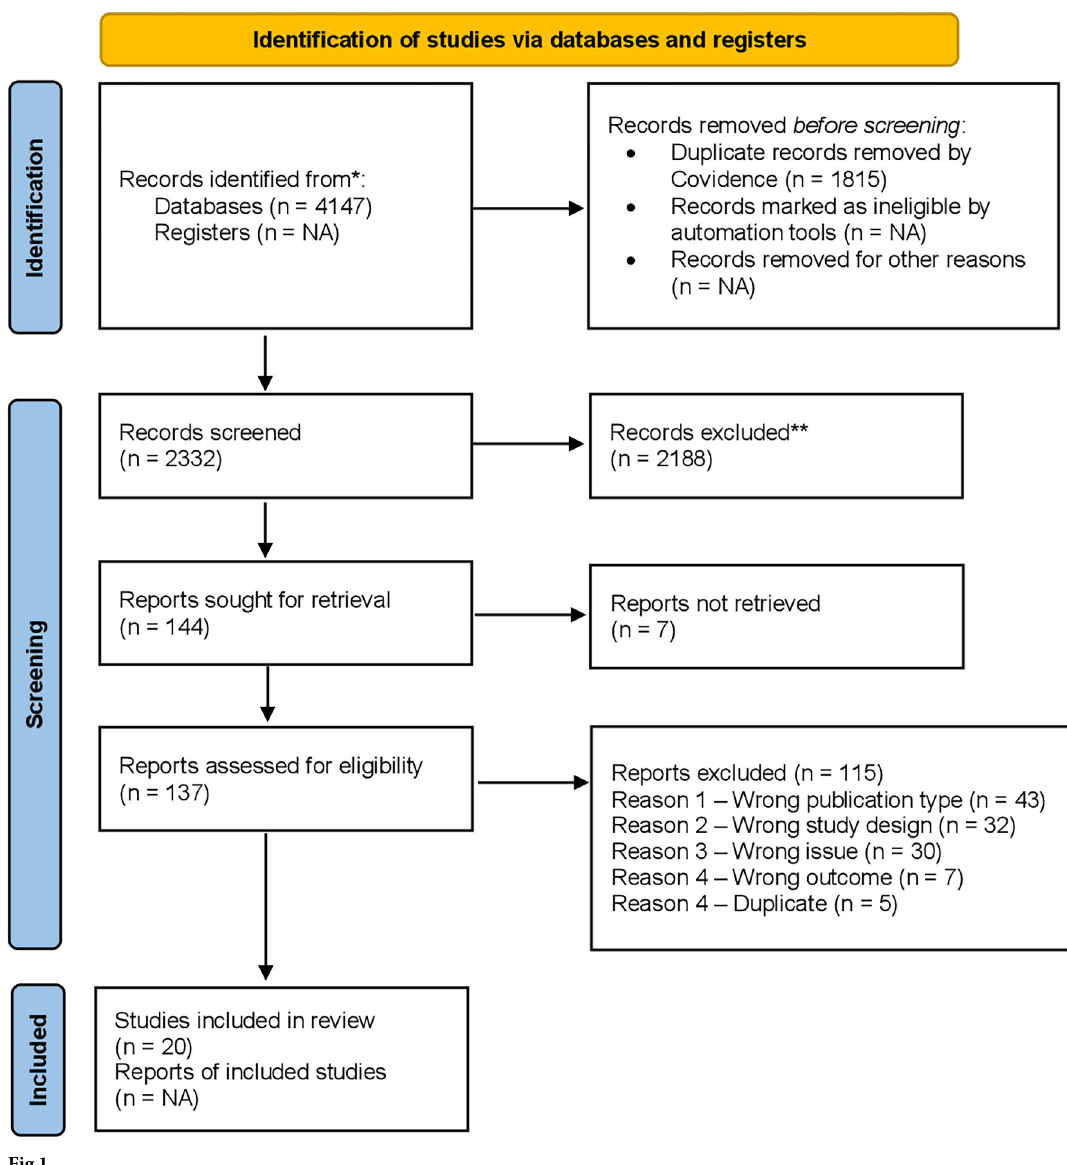
barriers and facilitators, in which one team member grouped the same barriers and facilitators together and listed all the studies in which these barriers or facilitators were identified (includ- ing the passage mentioning the barrier/facilitator and its location in the full-text